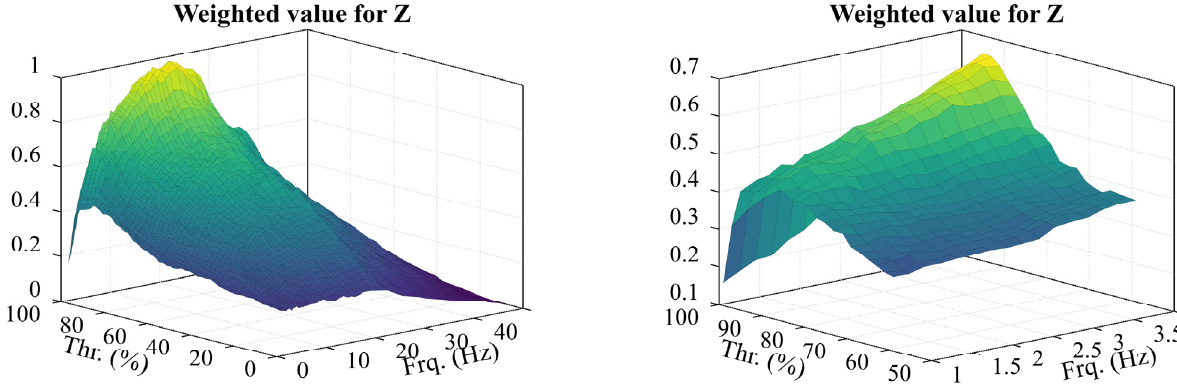
Figure 23. Estimates of weighted values concerning the variable frequency range (on the right, a narrower section of frequencies and relative threshold parameters is shown in comparison with the one on the left) along the Z-axis.